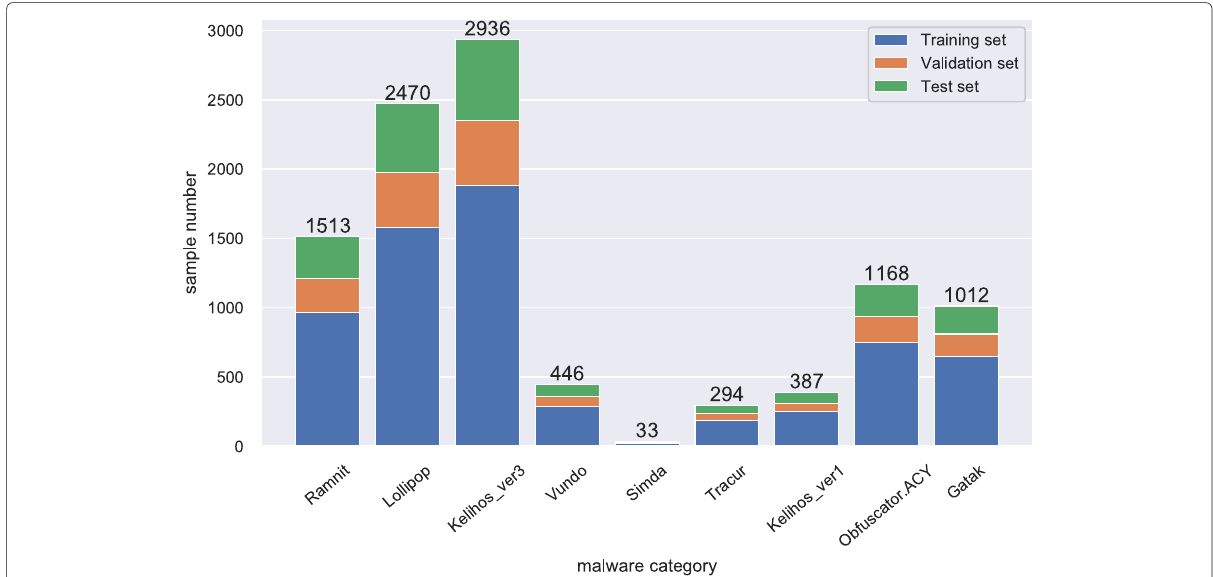
Fig. 5 Data statistics of the malware dataset for each category. The number above the bar is the total number of the corresponding